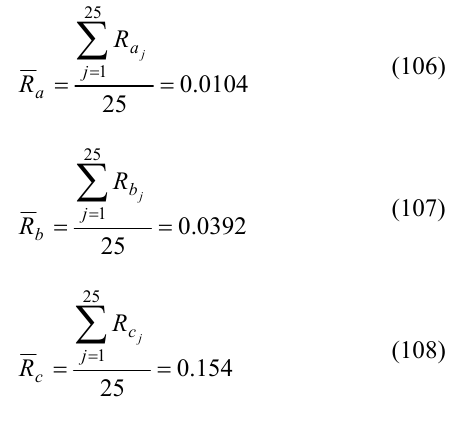
~ ~ - regression and R control charts Step 2: Fuzzy X were developed by using “Eq.( 29-31)” and “Eq. (81-83) for inner diameters of natural gas